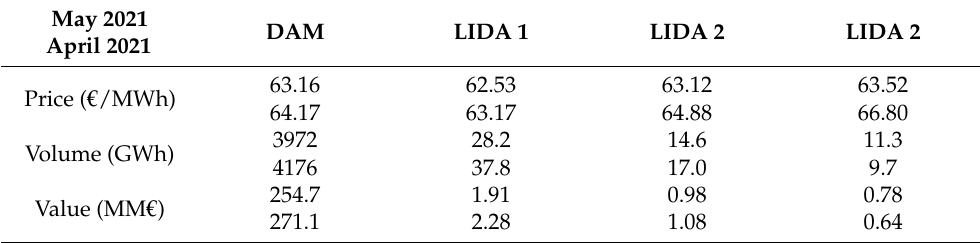
Table 1. Summary of the main figures from DAM & LIDAs (April & May 2021), Source: Hellenic Energy Exchange and Authors’